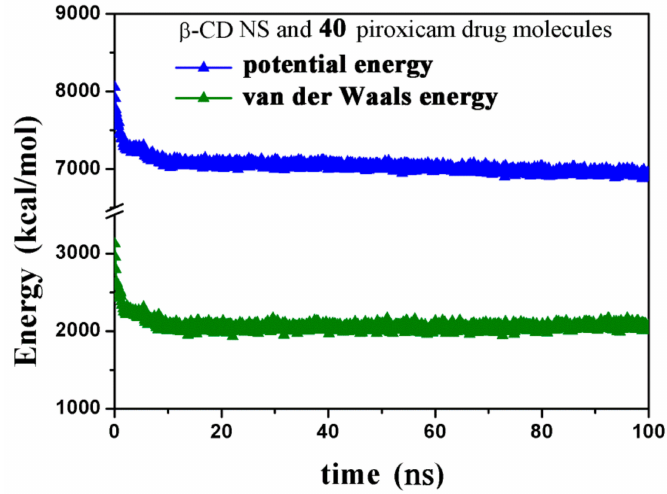
components for the NS model and 40 PX